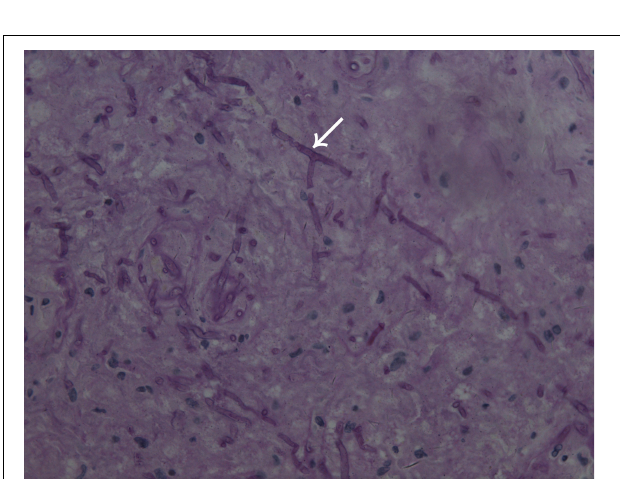
FIGURE 2 | Microscope image of biopsied lesion tissue showing numerous hyaline and septate hyphae with branches at acute angles scattered in the dermis (arrowhead) (periodic acid–Schiff, original magnification × 400).